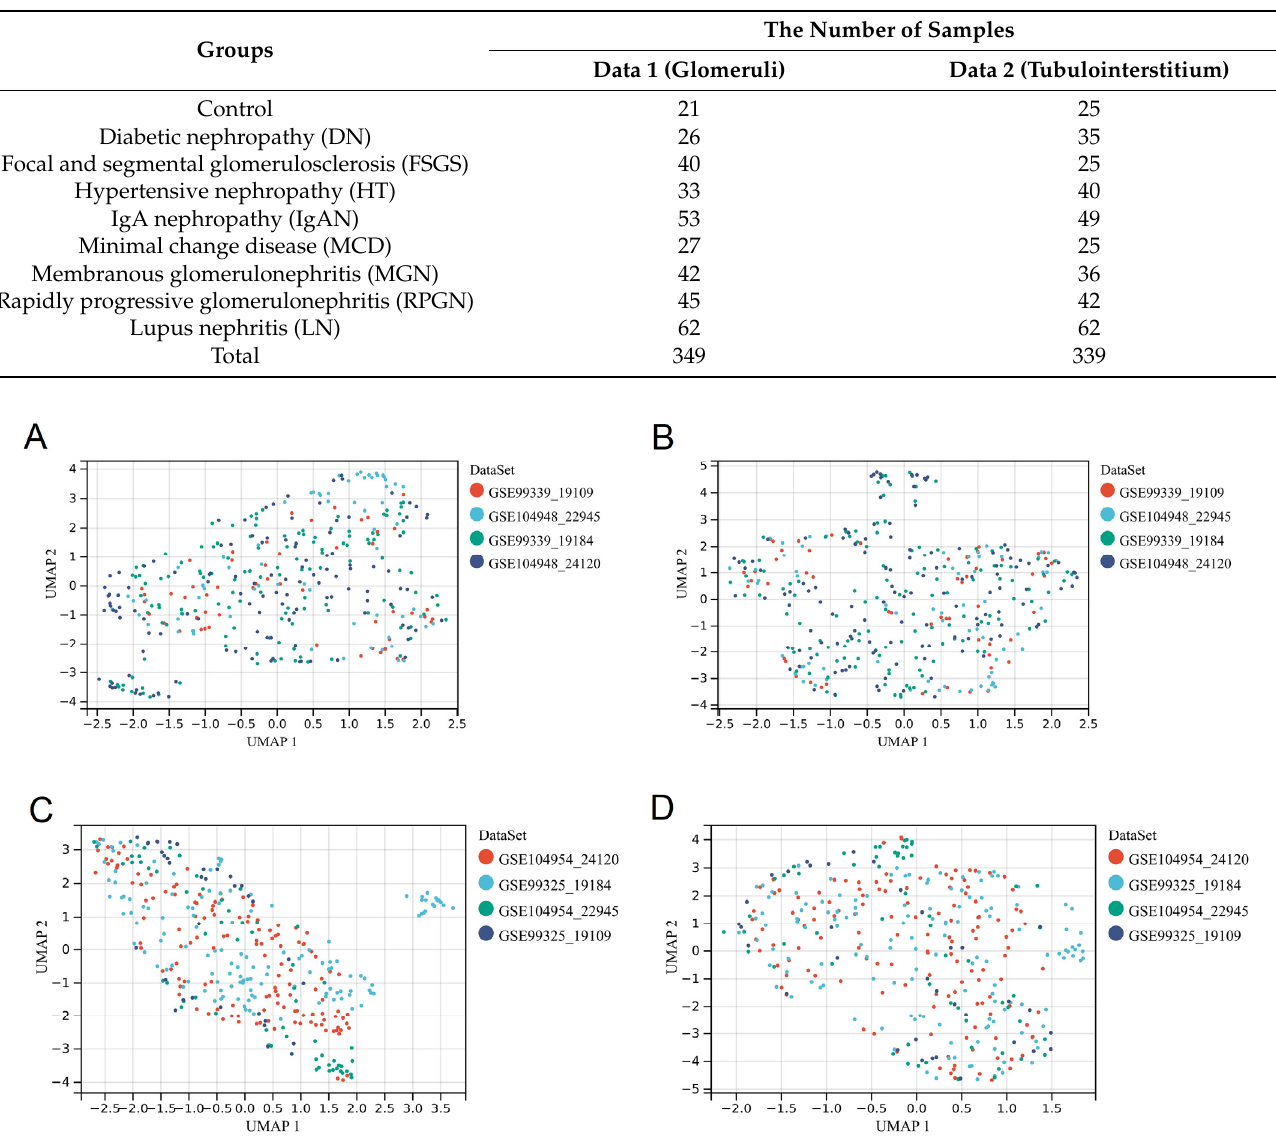
Table 2. The information of all samples in data 1 and data 2.